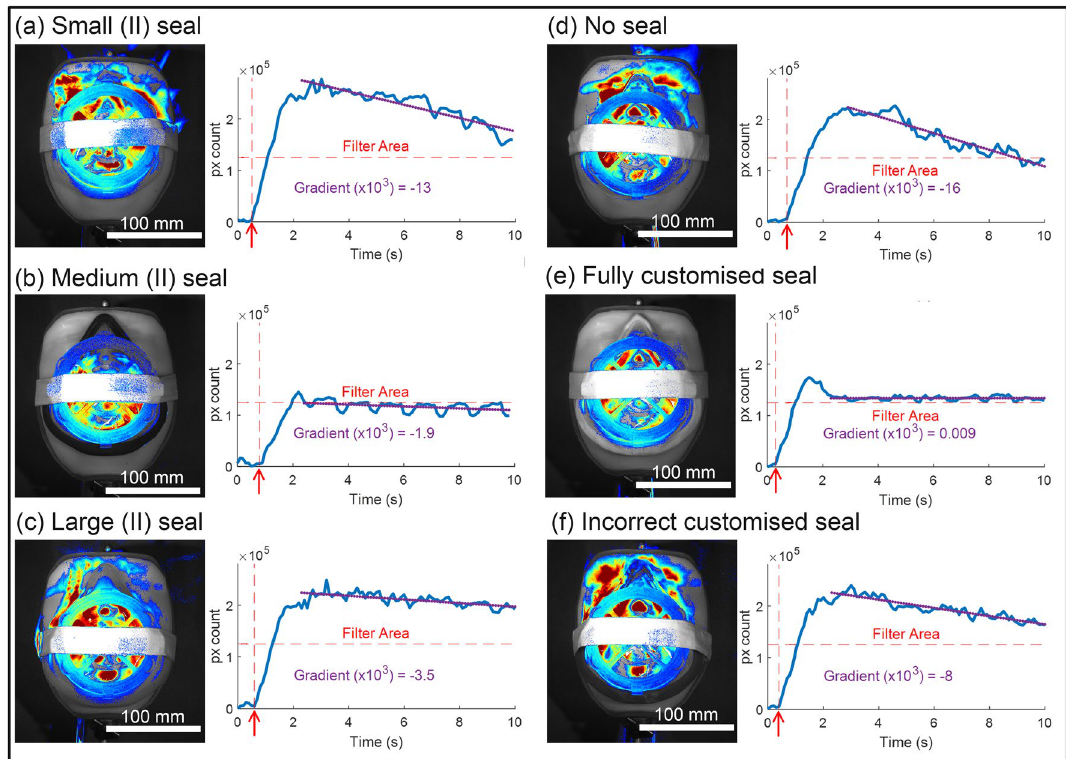
Figure 6. Figure showing typical false colour vapour visualisations for ( a ) ‘Small’(II), ( b ) ‘Medium’(II), ( c ) ‘Large’(II), ( d ) no seal condition, ( e ) fully customised seal, and ( f ) an incorrectly customised seal. Alongside each is resented the corresponding vapour pixel count against time for the fully analysed video. Horizontal dashed lines indicate a pixel count corresponding to the filter area, vertical dashed lines (red arrow) indicate the moment of vapour